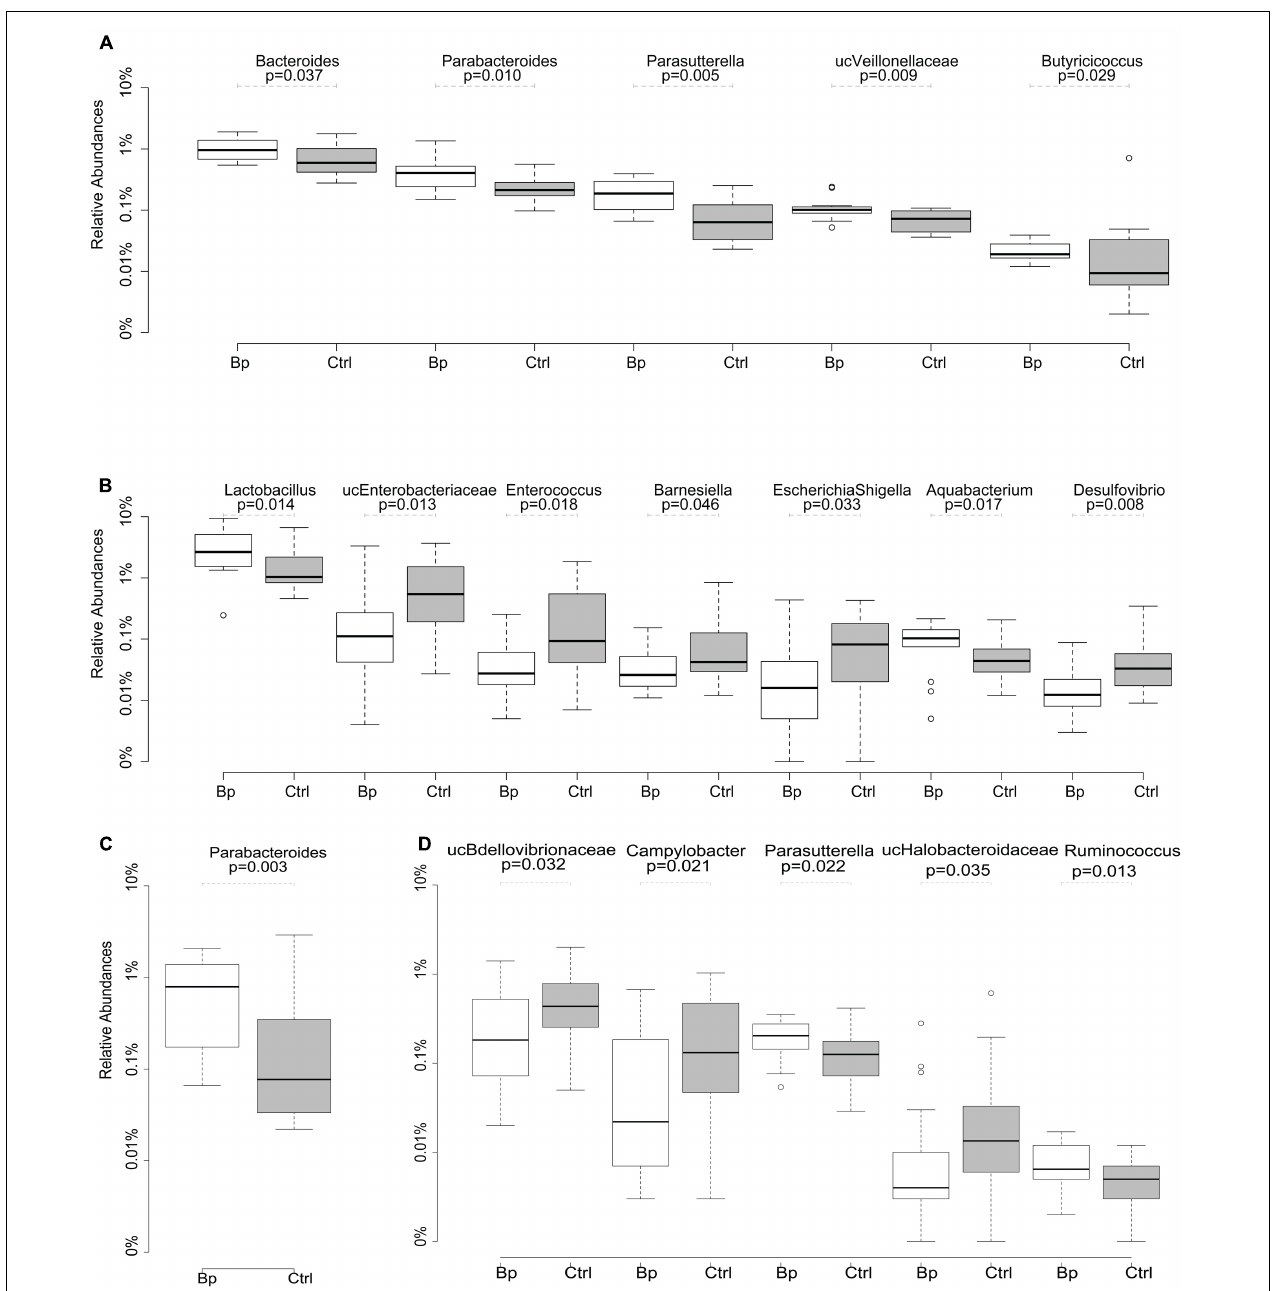
FIGURE 1 | Relative abundance (percent) of major bacterial genera determined using Ilumina MiSeq sequencing, that showed significant differences in ileum at day 26 (A) and day 40 (B), and in caecum at day 26 (C) and day 40 (D) between the ctrl (received unsupplemented feed) and the Bp (received feed supplemented with 10 9 cfu Butyricicoccus pullicaecorum per kg feed) group. Abundances are expressed in log scale. o,